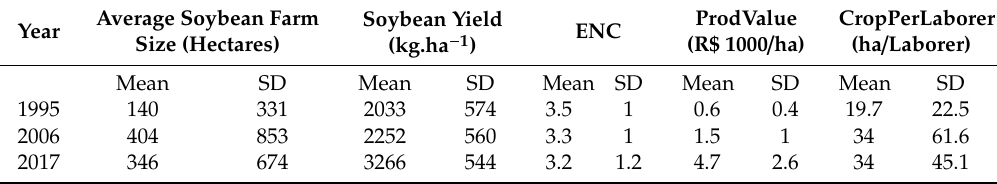
Figure 3. Results from statistical analysis according to variable outcomes by farm size class across agricultural censuses years. Inferential error bars of confidence intervals at 95% for the mean value of each variable in classes of soybean farm size, for 1995, 2006, and 2017 in Brazil. The results are from Kruskal–Wallis tests for the 3 years (using statistical significance threshold p = 0.01) with n = 1136, 1588, and 2190 for soybean yield ( a , e , i )/effective number of crops (ENC, ( b , f , j) )/ProdValue ( c , g , l )/CropPerLaborer ( d , h , m ) observations (municipality) in 1995, 2006, and 2017, respectively. Table 2. Summary statistics for variables used in the study.